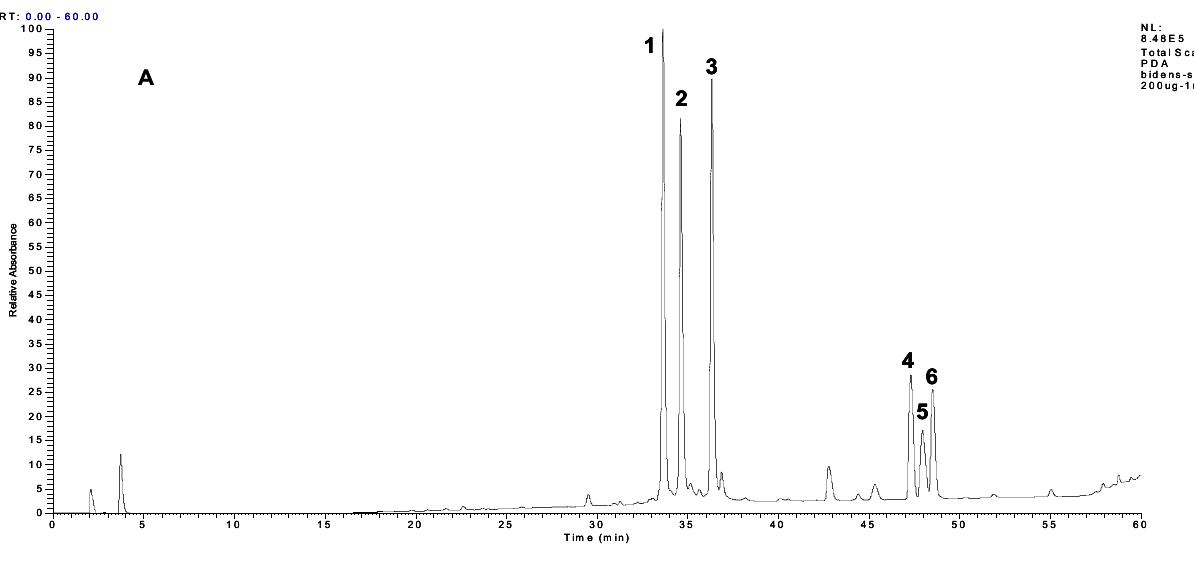
Figure 4. Representative HPLC chromatograms: ( A ) the purified six authentic compounds; ( B ) aqueous extract, crude methanol extract and its different solvent partition fractions (1 mg/mL) of flower part of BPR. AE: aqueous extract, ME: methanol extract, remaining aqueous fraction. The peak number and its chemical structure are referred to Figure 2. Characteristic UV spectra, negative- ESI and APCI mass spectra are referred to Figure 3A,B,